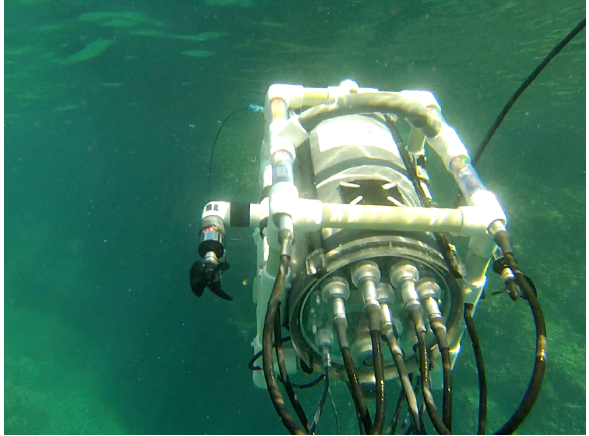
Figure 5. Our underwater vehicle: Ryujin.